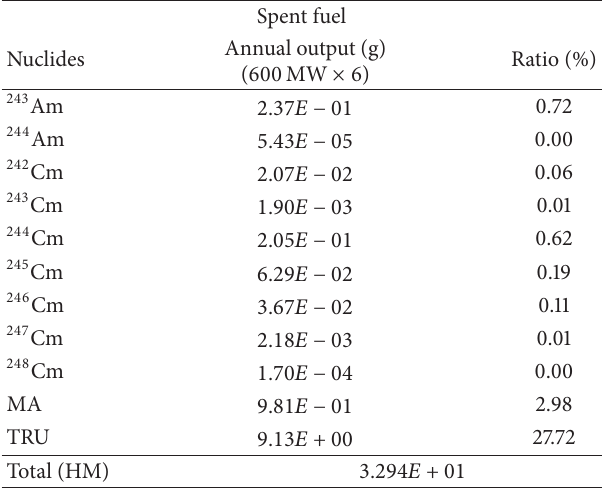
Table 2: Characteristics of reference SFR spent fuel.